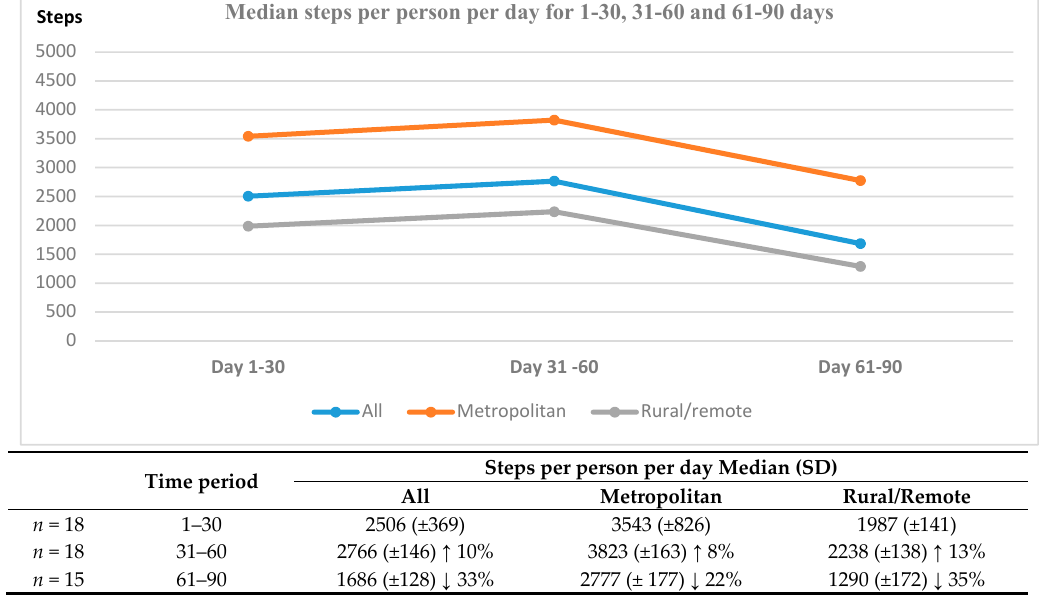
Figure 2. Participants objectively measured physical activity.